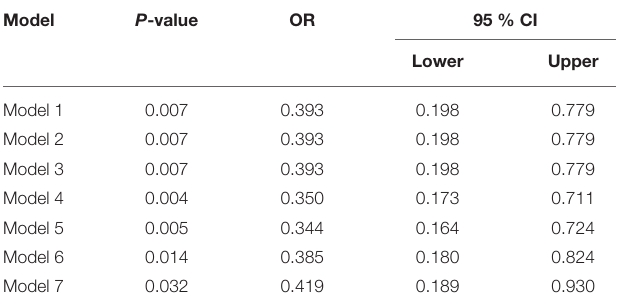
TABLE 3 | Relationship between subtypes of revascularization and rebleeding. Model